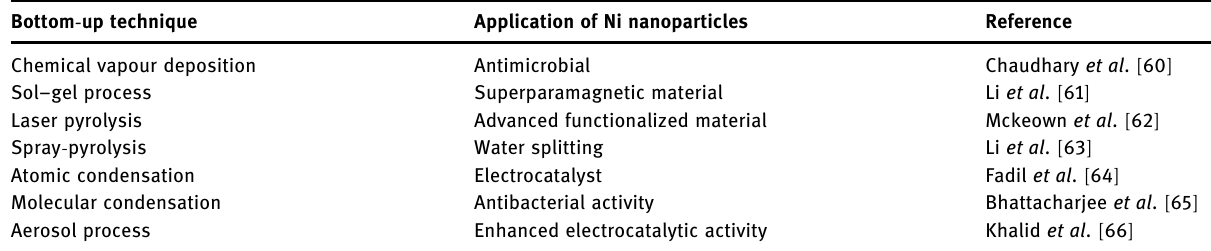
Table 2: Selected bottom - up techniques for Ni nanoparticles production Bottom - up